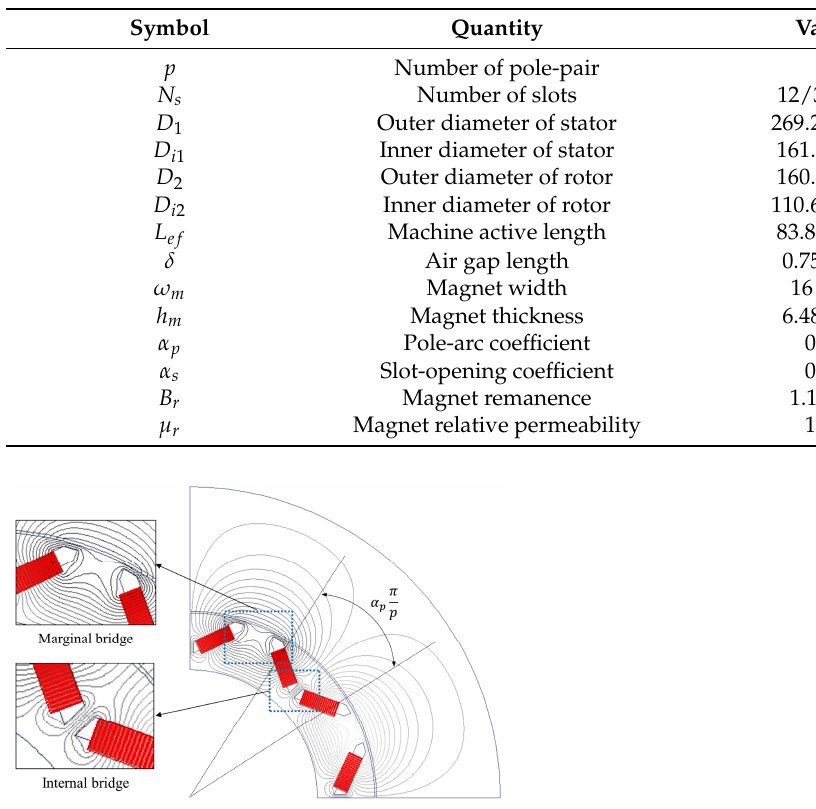
Table 1. Main parameters of the selected machines.